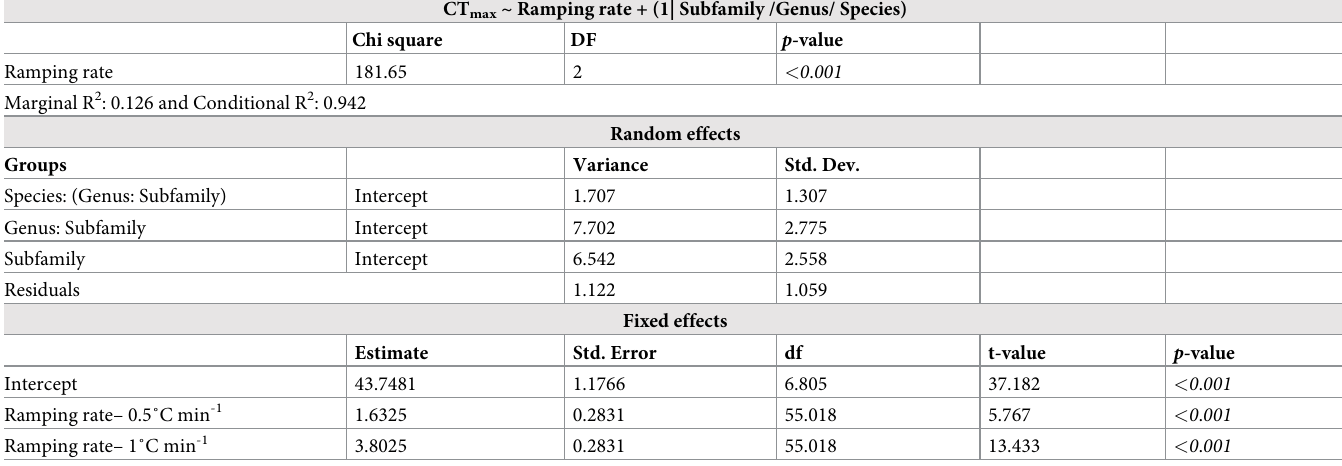
Table 1. Outcomes of the linear mixed model examining the relationship between parameters (CT max , ramping rate and species identity as well as the genus and subfamily identity) by linear mixed model for the dynamic assay with white-adjusted p -value. CT max ~ Ramping rate + (1| Subfamily /Genus/ Species) Chi square DF p -value Ramping rate 181.65 2 < 0 . 001